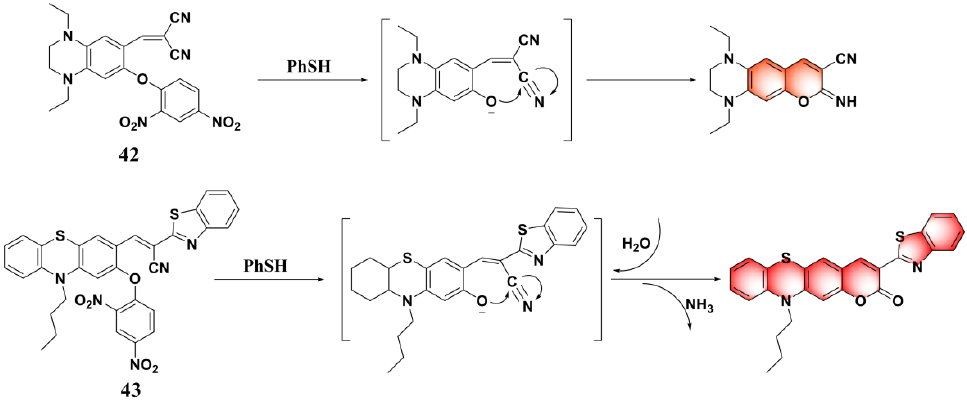
Figure 18. Structures and sensing mechanisms of probes 42 – 43 for PhSH.